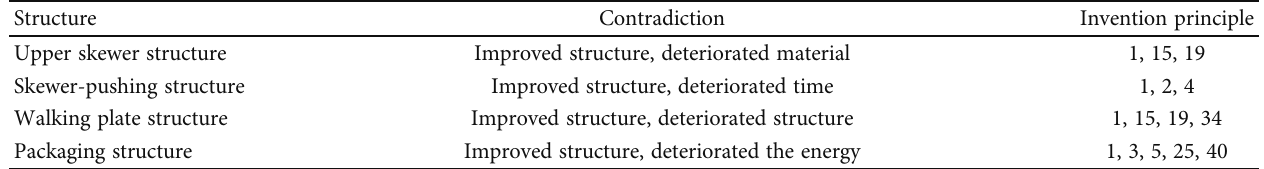
Table 1: The correspondence between the structure, contradiction, and invention principle.